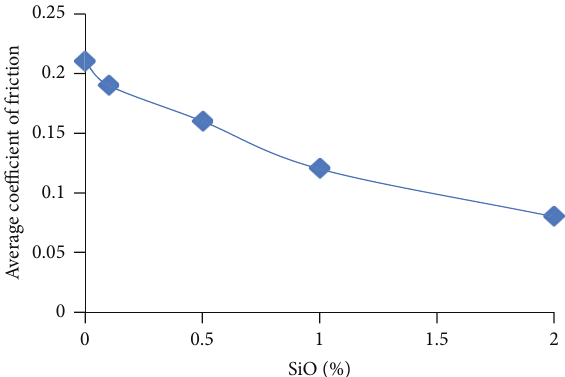
Figure 20: Variation in coefficient of friction of EN-coatings as a function of SiO with surfactant (SLS) in EN bath.